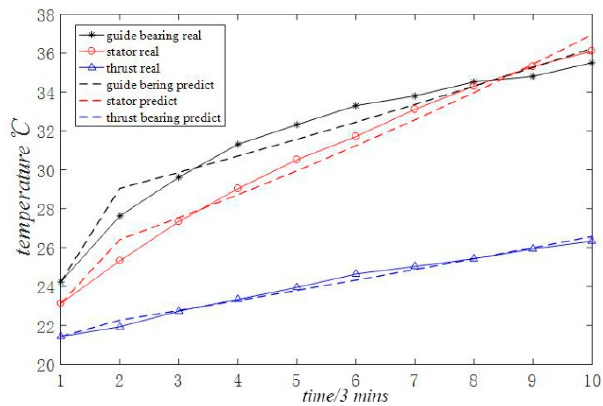
Figure 4. MGM (1, 3) model prediction effect.